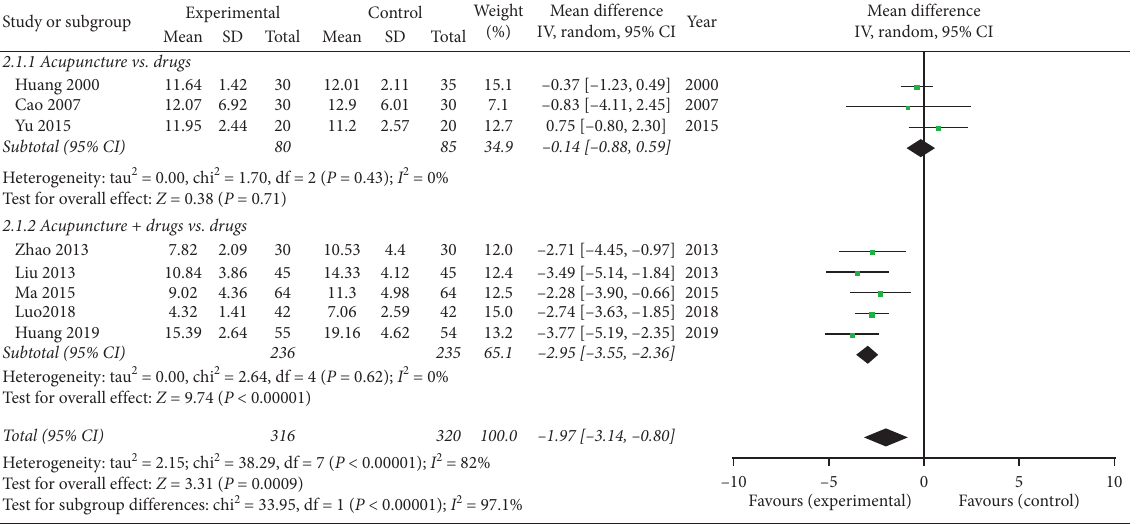
Figure 4: Meta-analysis for the HAMD score of acupuncture versus the control group.